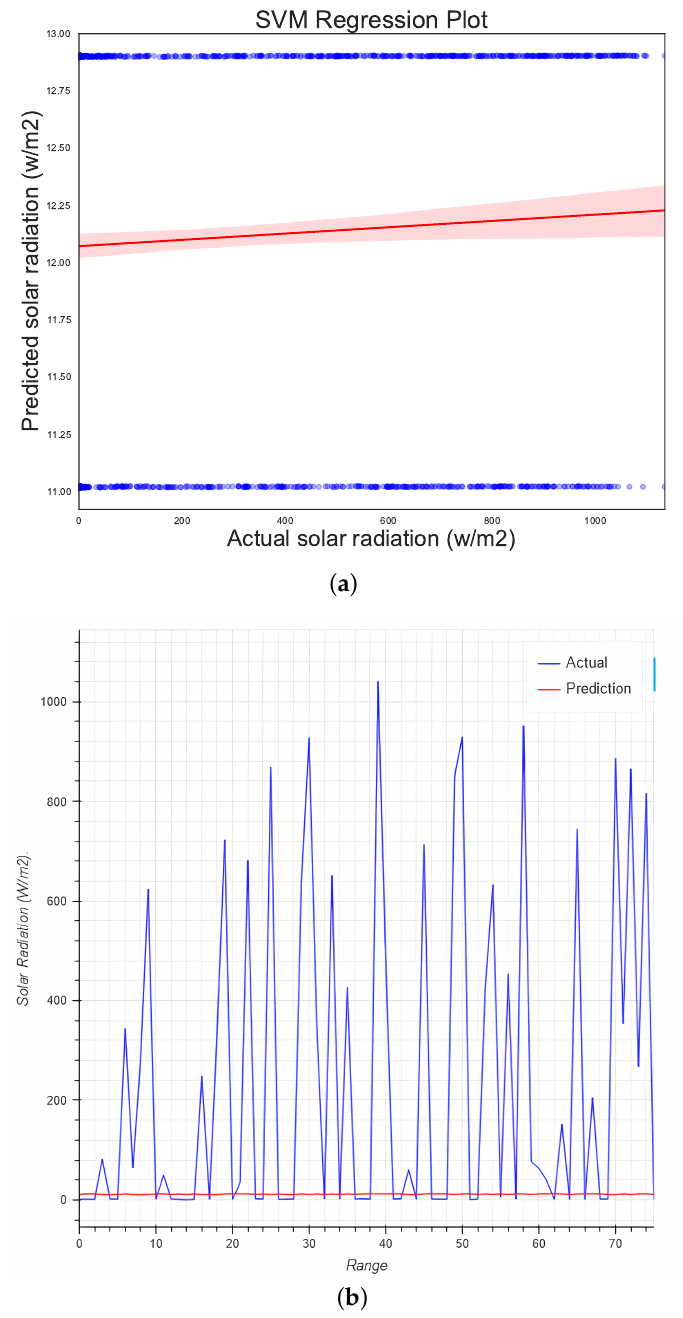
Figure 10. Regression plots for ( a ) the MPL model and ( b ) the test data using MPL